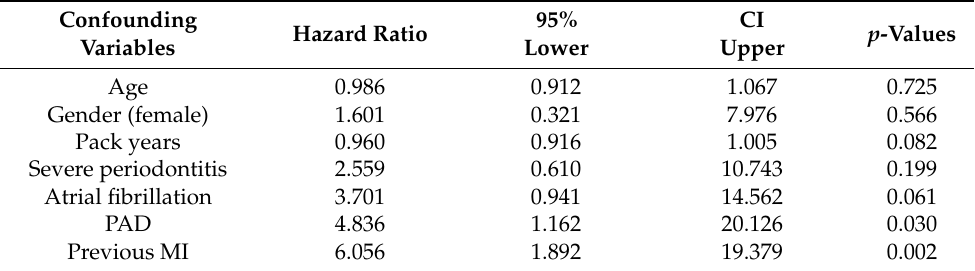
Table 4. Hazard ratios (HRs) for new cardiovascular events adjusted for age, gender, pack years, severe periodontitis according to CDC classification, atrial fibrillation, peripheral artery disease (PAD), and previous myocardial infarction